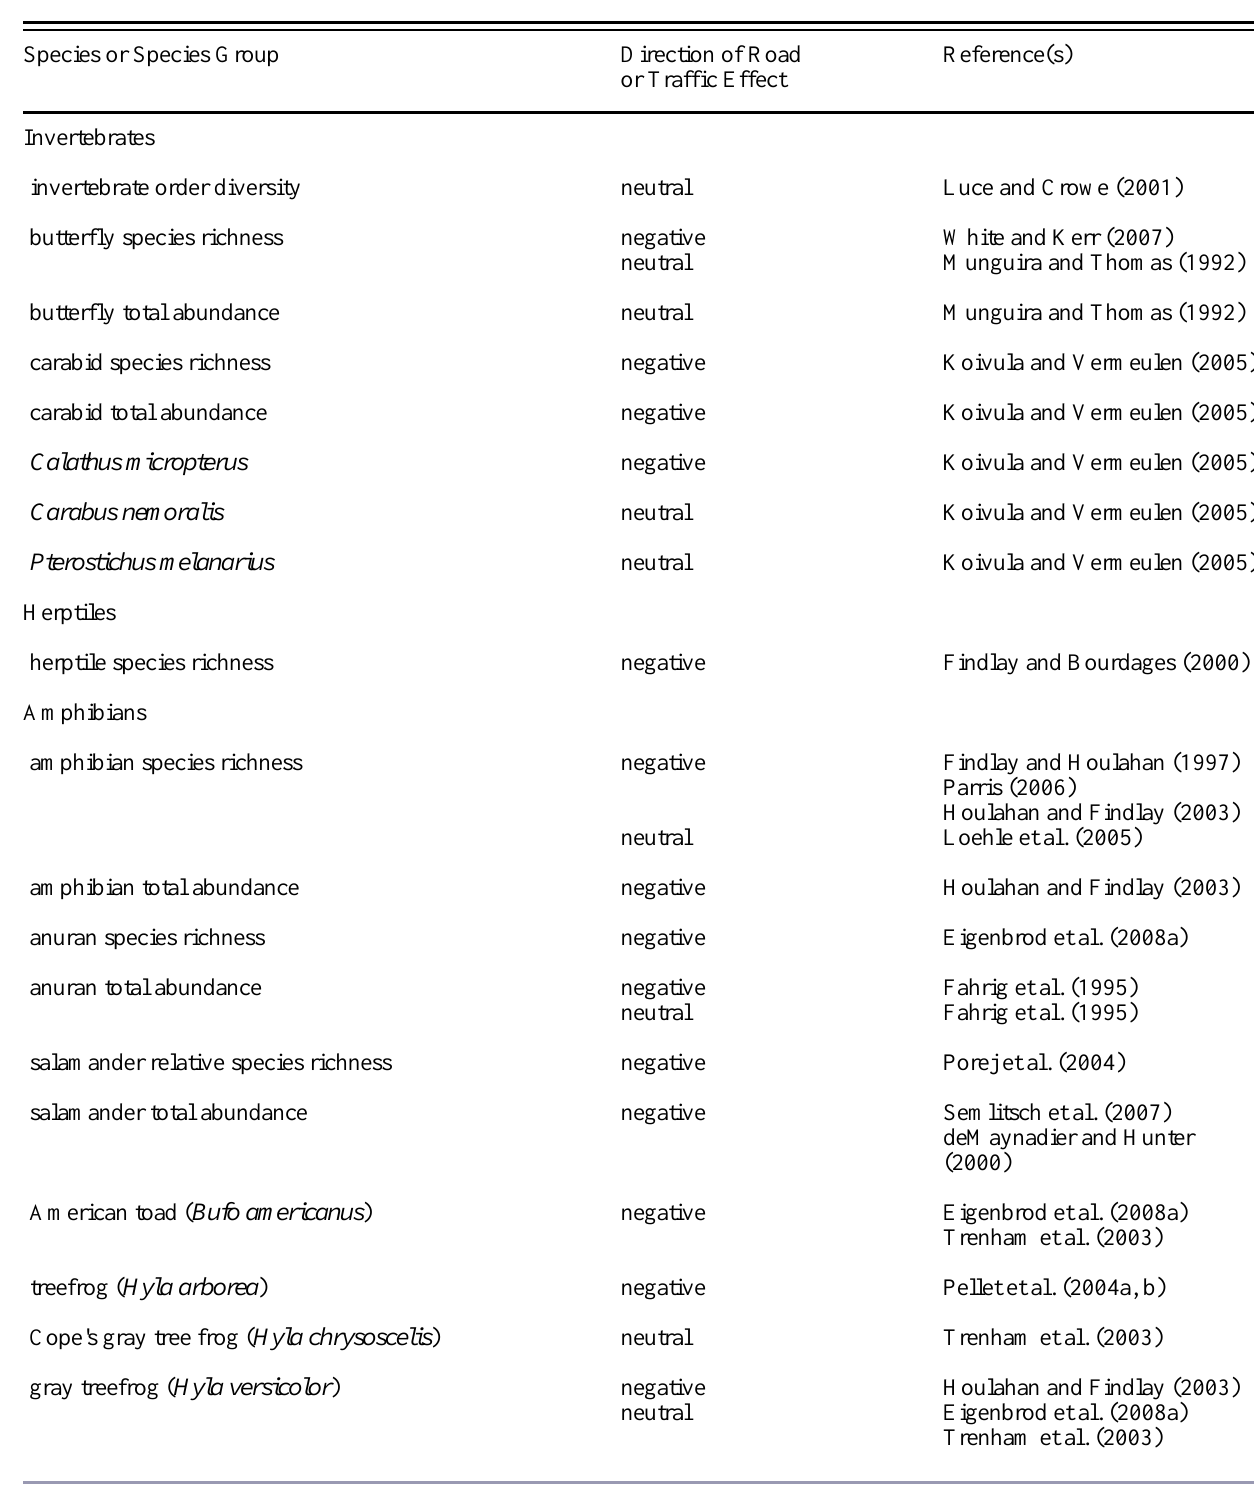
Table 1. Documented effects of roads and traffic on animal